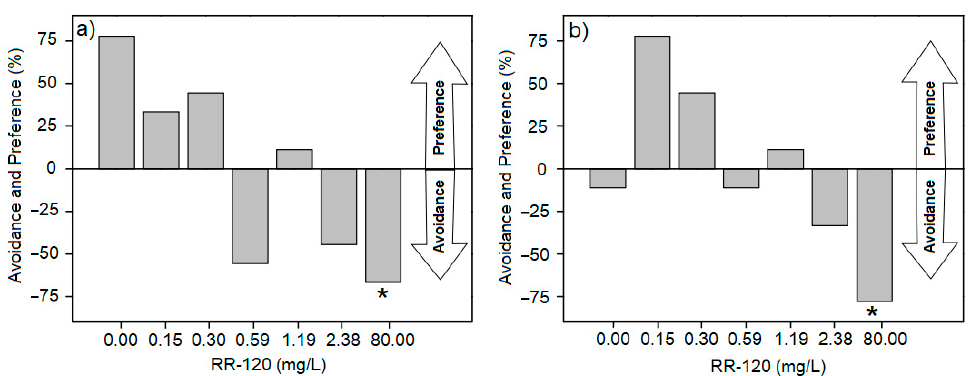
Figure 2. Preference and avoidance responses (%) of zebrafish exposed to untreated, treated and dilutions of treated synthetic waters from the textile industry: ( a ) after 4 h of exposition, and ( b ) after 6 h of exposition. Data were pooled from 3 replicates; therefore, the standard deviation is not presented. Asterisks represent statistically significant differences ( p < 0.05) in the distribution of organisms when compared with the distribution in control (Fisher’s exact test (2 × 2); see Tables S5 and S6 in Supplementary Material).